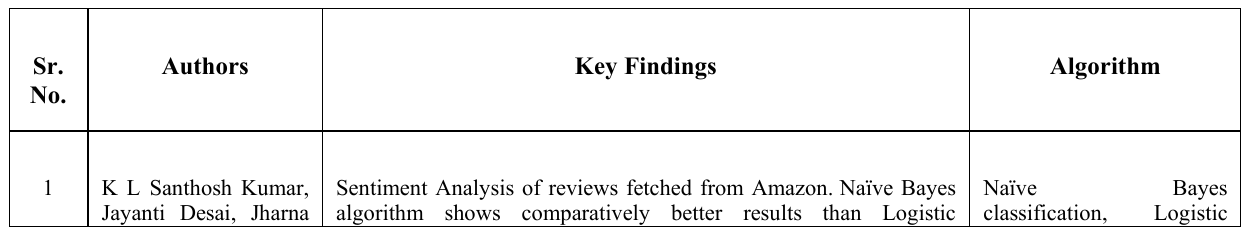
Table 1. Summary of Literature